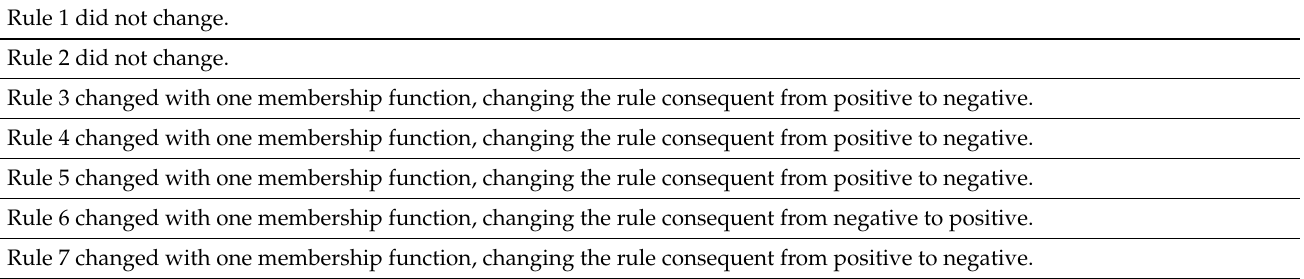
Table 4. Interpretability with respect to (degree of) changes in fuzzy neurons during the evolv- ing